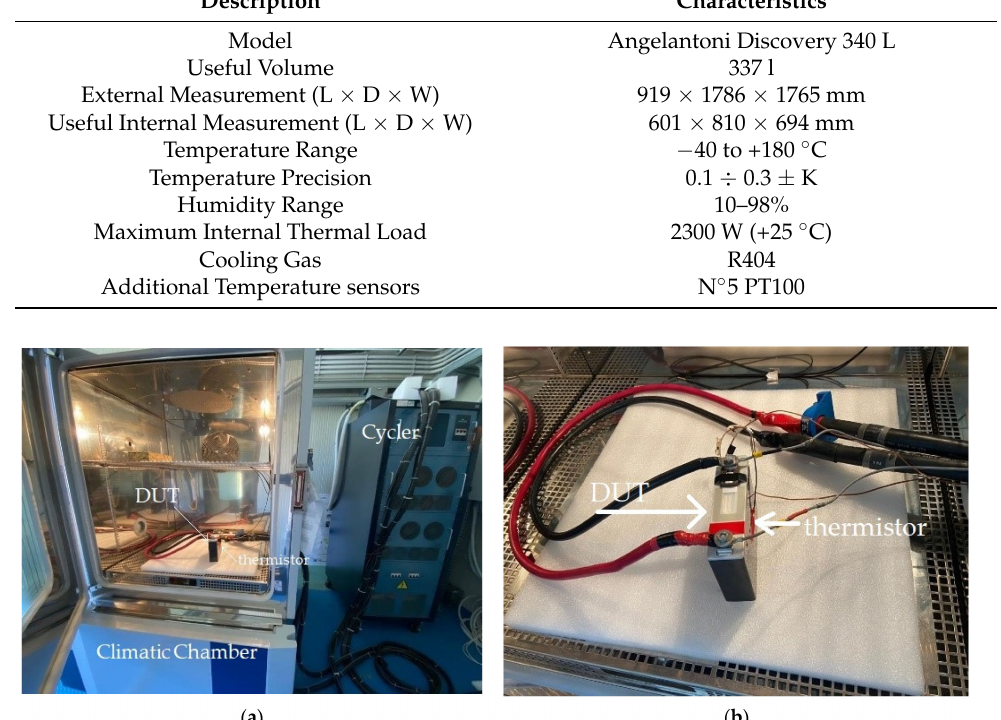
Figure 7. ( a ) Bitrode cycler on the right and Angelantoni climatic chamber on the left; ( b ) DUT inside the climatic